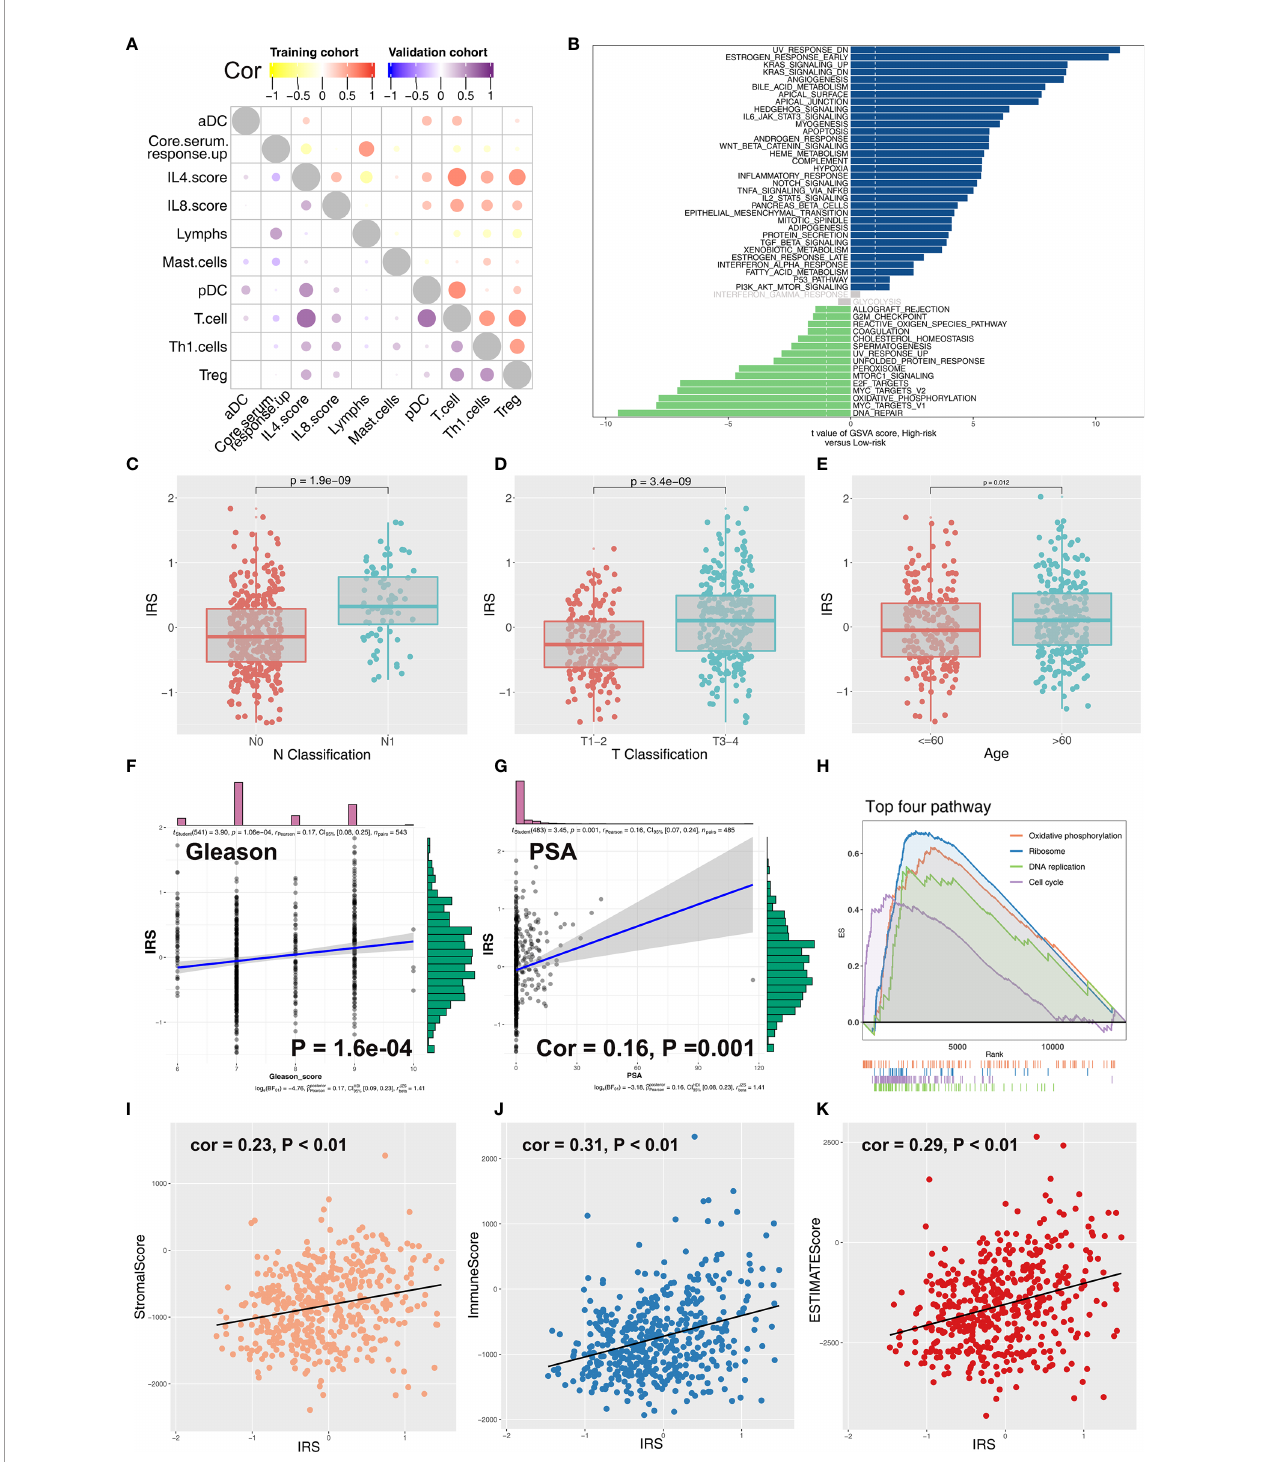
FIGURE 4 | Correlation between IRS and clinical features of PCa patients. (A) Coexpression relationship between 10 model immune terms. (B) GSVA analysis of IRS signature. The upregulated pathways in high IRS patients are shown in dark blue and the downregulated pathways are shown in green. (C – G) The correlation between IRS value and N classi fi cation, T classi fi cation, age, gleason score, and PSA. (H) GSEA analysis of IRS signature. (I – K) The correlation between IRS value and immune score, stromal score, and estimate